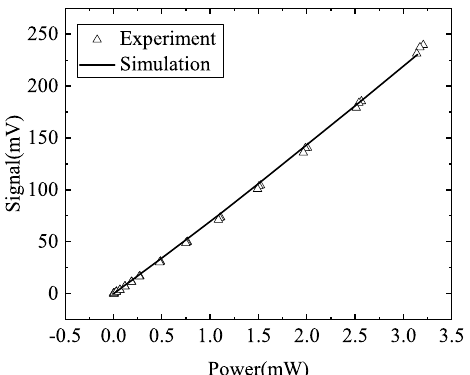
Figure 4. Comparison between simulated and experimentally generated thermoelectric voltages, by a heated pixel at electrical powers from 0 to 3.5 mW.